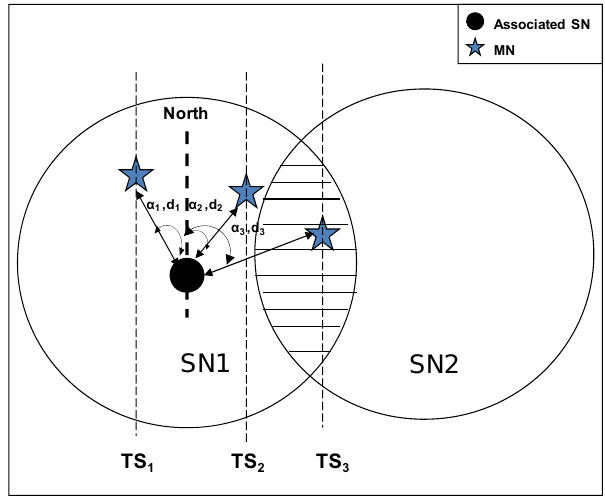
Figure 3. Next node activation process using AoA method.